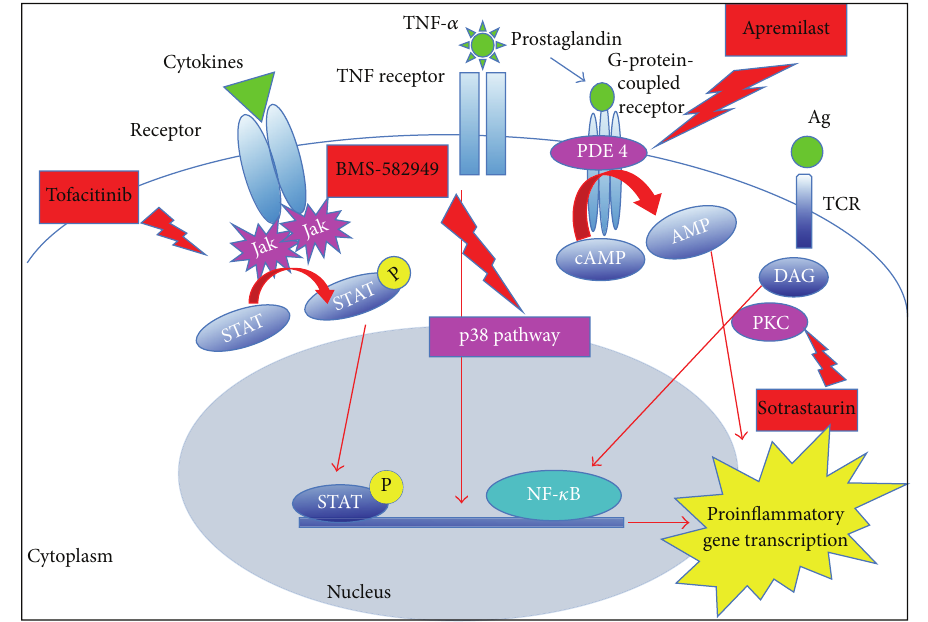
Figure 2: Schematic representation of the mechanism of action of the small-molecule inhibitors. Jak: janus kinase; STAT: signal transducing proteins and activator of transcription; STAT-P: phosphorylated STAT (active); PDE 4: phosphodiesterase 4; NF-KB: nuclear factor kappaB; PKC: protein kinases C; DAG: diacylglycerol; cAMP: cyclic adenosine monophosphate; AMP: adenosine monophosphate.